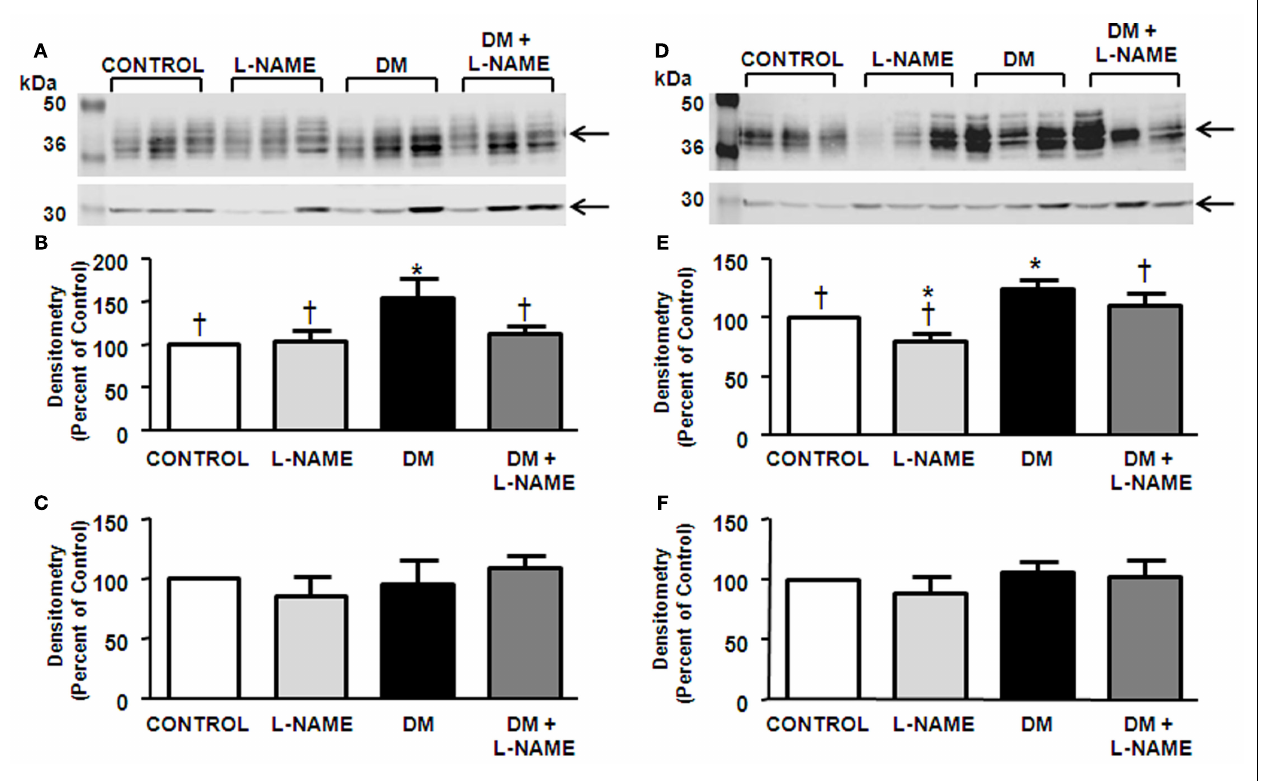
glycosylated AQP2 (A,D) and at a higher intensity to measure the unglycosylated AQP2 (A,D) however, images are gleaned from the same representative western blot.The experimental conditions were performed five times ( n = 5) where there were five animals per experimental group in each cohort. In total, 25 animals per experimental group were analyzed. * p < 0.05 compared to control, † p < 0.05 compared to